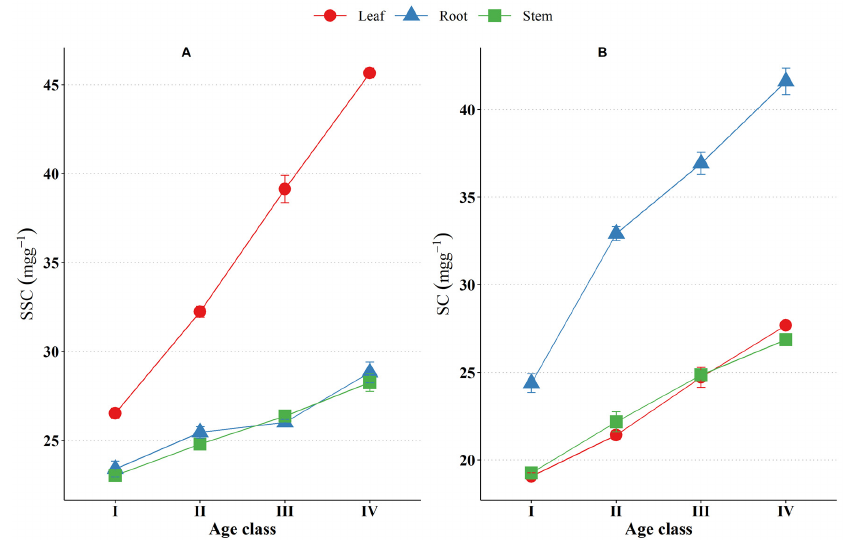
Figure 7. Changes of soluble sugar ( A ) and starch contents ( B ) in the roots, stems, and leaves with the increasing age of Quercus acutissima seedlings. SB was negatively correlated with LMR, LAR, P/NP, SRL, and SRA, and positively correlated with RMR, TRL, RV, RAD, RSS, SSS, LSS, RS, SS, and LS (Figure 8). LMR, LAR, and P/NP were negatively correlated with RMR, TRL, RV, and RAD. RSS, SSS, LSS, RS, SS, and LS were negatively correlated with LMR, LAR, P/NP, SRL, and SRA, and posi- tively correlated with RMR, TRL, RV, and RAD (the correlation between SS and RMR was not significant).